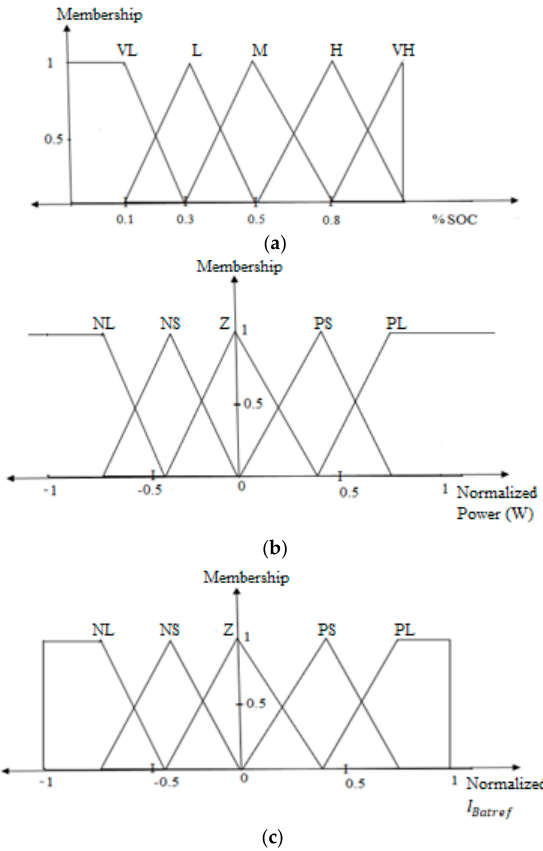
11 of 23 Figure 7. Rule-based control flowchart [56].